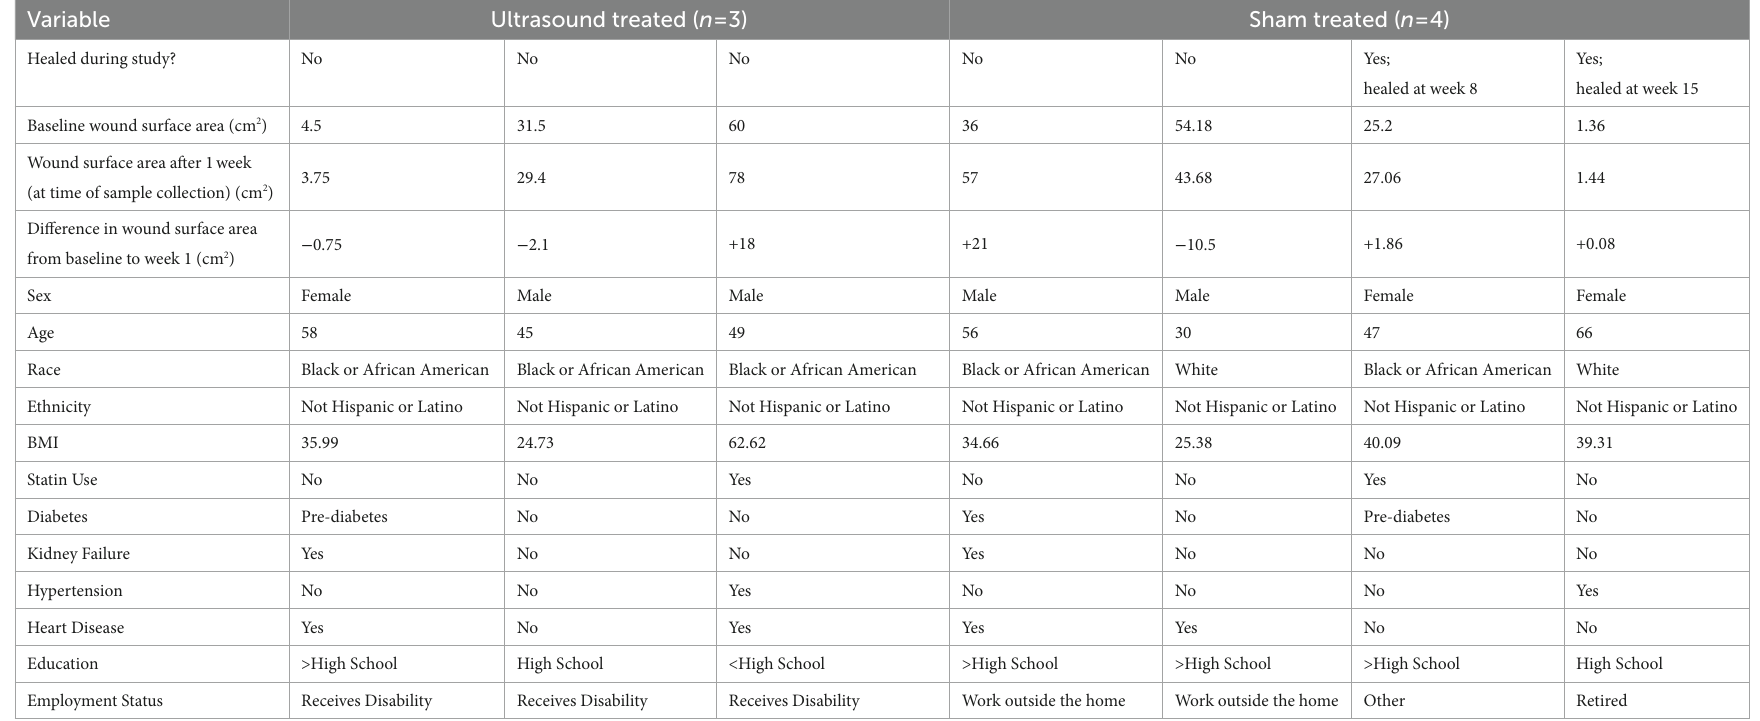
TABLE 1 Subject demographics of analyzed wound tissue samples.